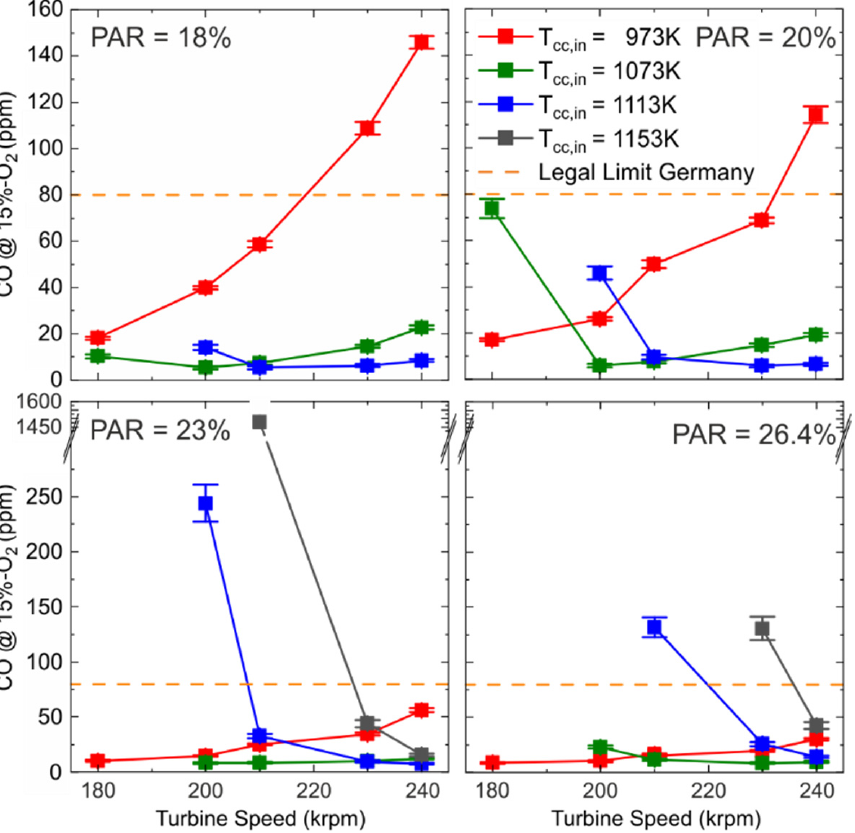
Figure 9. CO emissions as a function of turbine speed for different combustor inlet temperatures T cc,in .